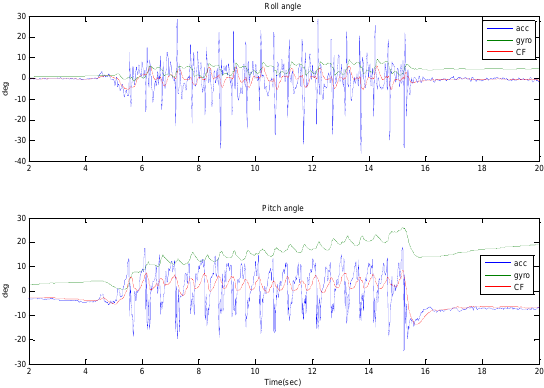
Figure 8. Handheld type